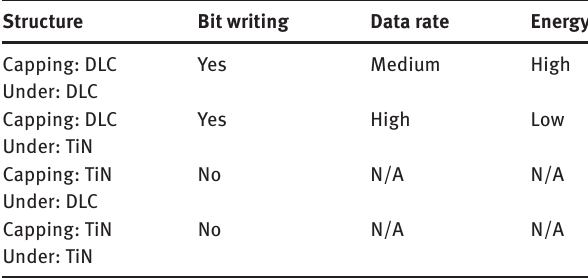
Table 1: The performance comparisons among the PCPMs with dif- ferent